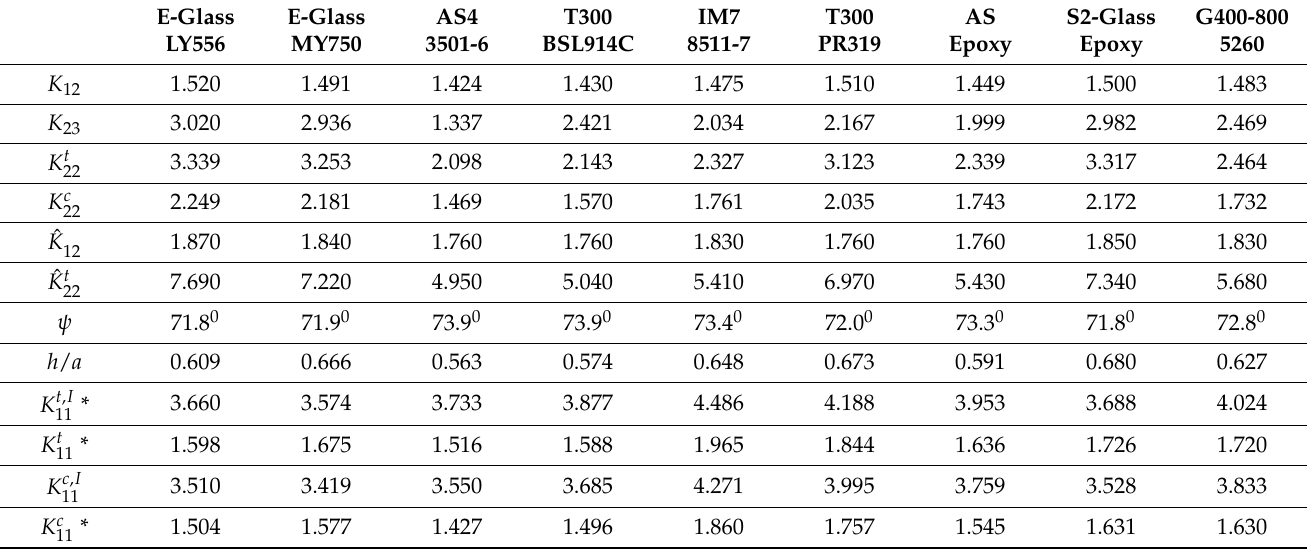
Table 1. Matrix SCFs with other relevant parameters of the nine composite systems used in WWFEs.